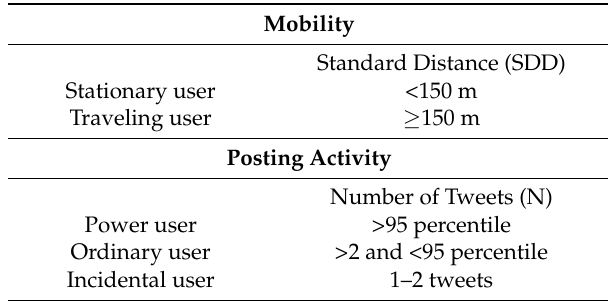
Table 2. Classification values used in assigning users to different